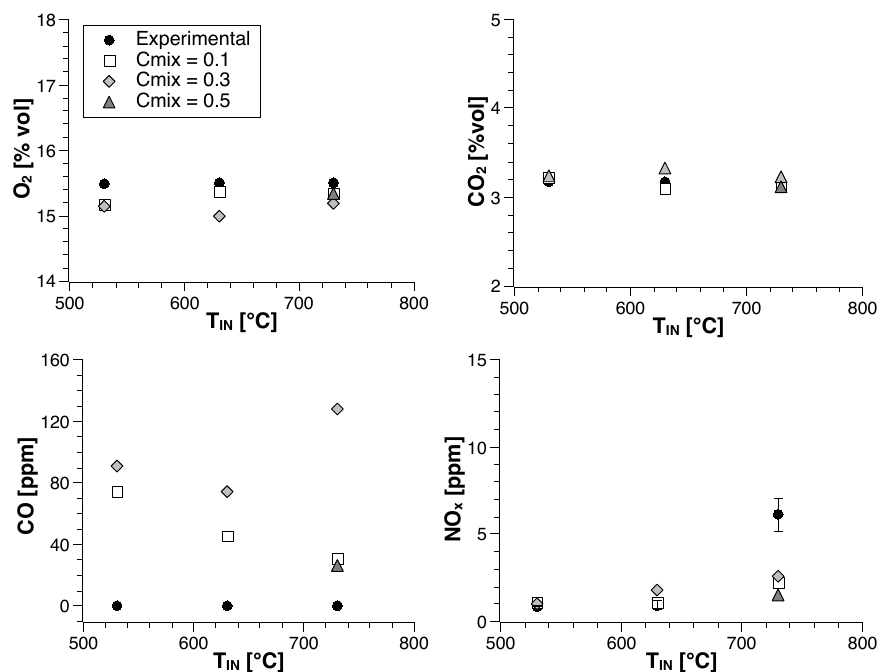
Figure 17. Comparison between measured and computed values of O 2 (% vol), CO 2 (% vol), CO (ppm), and NO x (ppm) concentrations in the exhaust gas for different values of the mixing timescale constant C mix , and for different values of the air inlet temperature. λ = 3.5. KEE58 kinetic mechanism.